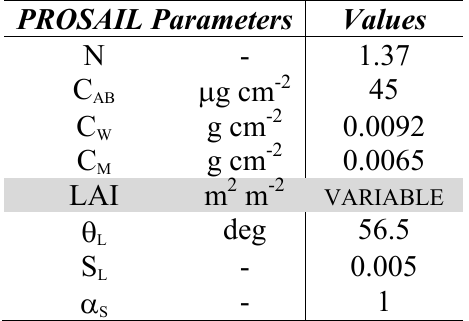
Table 1. Parameterization of PROSAILH: leaf structure parameter (N), chlorophyll a+b concentration (C ), leaf water content (C ), dry matter content (C AB w (LAI) mean leaf inclination angle ( θ ), hot spot size parameters (S L ). LAI is variable because it is estimated daily by brightness factor ( α S